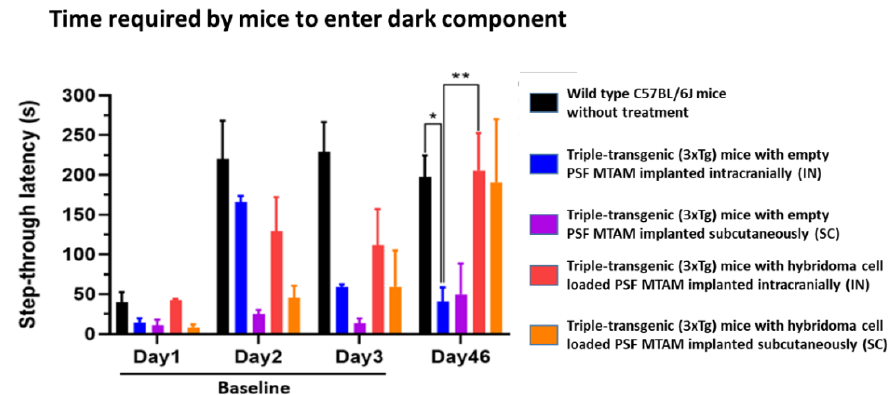
Figure 5. Passive avoidance test mouse models of day 1 to day 3 (baseline) and day 46 of the respective study groups. On day 3, wild-type mouse models registered a step through latency of 229 ± 84 s when compared to the 3xTg mouse with empty PSF MTAM implanted which registered a reading of 61 ± 103 s. At day 46, a statistically significantly different step through latency was observed when comparing the 3xTg mouse with empty PSF MTAM implanted and those implanted with hybridoma cell loaded MTAMs implanted; registering a reading of, intracranial implantation: 41 ± 39 s; vs 205 ± 124 s and subcutaneous implantation 50 ± 55 s vs 190 ± 112 s respectively (3xTg mouse implanted with empty MTAMs versus those implanted with cell loaded MTAMs). Two-way ANOVA with Tukey ’ s multiple comparisons tests. Significant impact p -value * p < 0.05, ** p < 0.01. Error bars in data represented + −⁄ 𝑺𝑫 . Wild-type, n = 7, empty MTAMs IN and SC, n = 5 and n = 2; hybridoma cell loaded MTAMs IN and SC, n = 7 and n = 2.